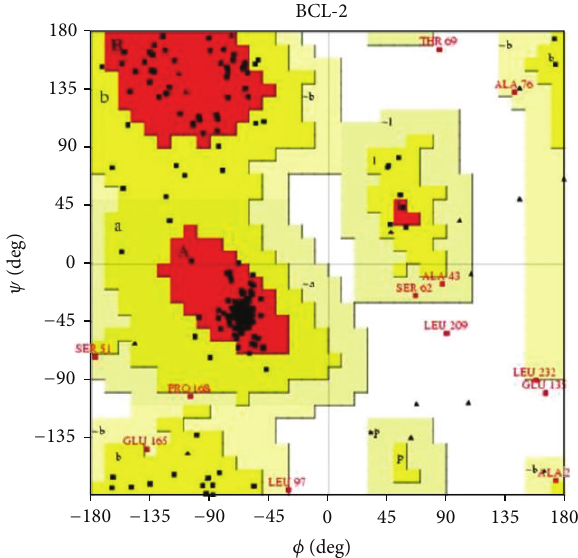
Figure 1: BCL-2 protein amino acids distribution in Ramachandran